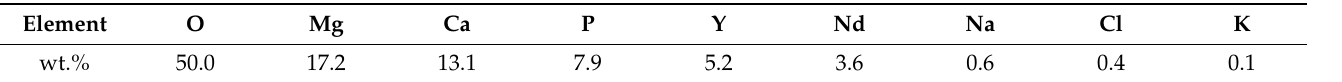
Figure 11. Surface of the 3D-printed alloy corroded in SBF solution (SEM) and element distribution maps (EDS). Table 6. EDS analysis of the corrosion products on the 3D-printed alloy after exposure in SBF